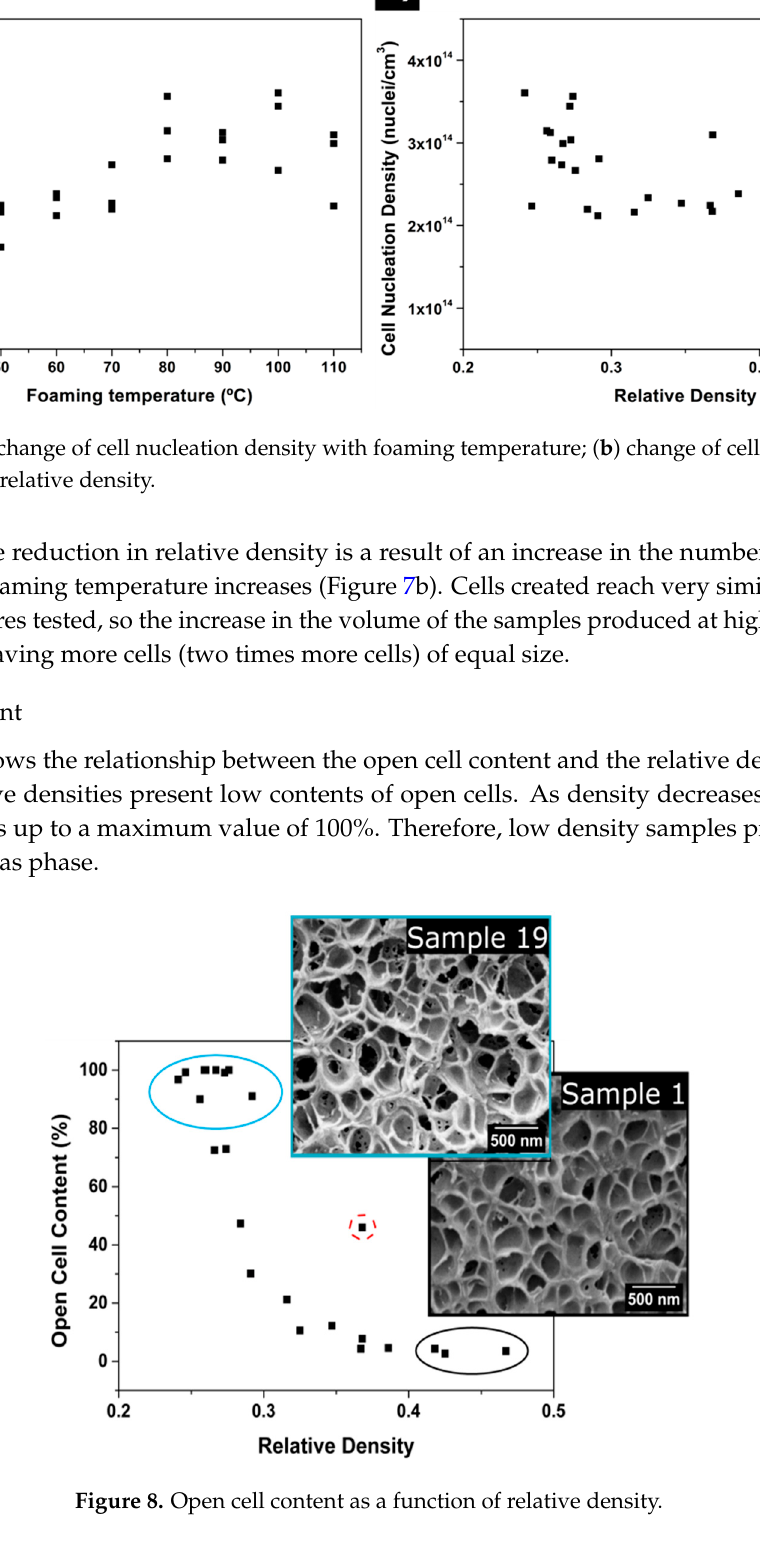
Figure 8. Open cell content as a function of relative density.